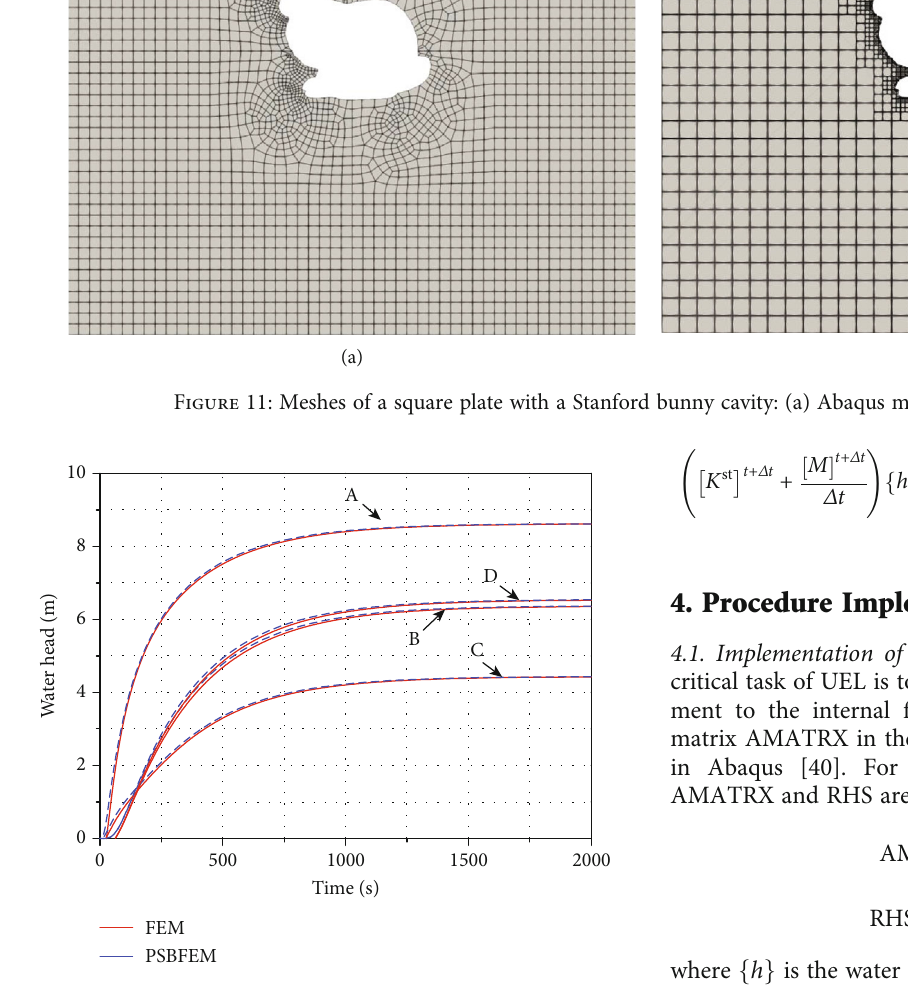
Figure 12: Comparison of the water head history of the four monitor points for the FEM and